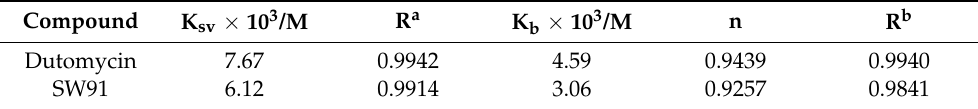
Table 3. Binding constant K b values of compounds dutomycin and SW91 interacting with CT-DNA-EB.